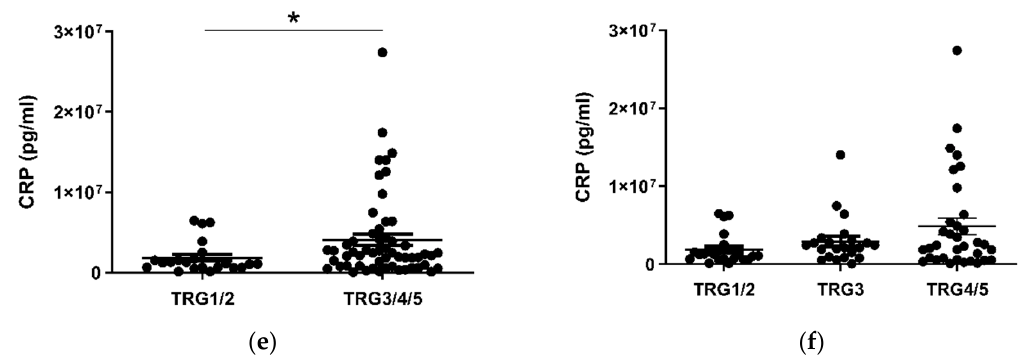
Figure 2. CCL4, Tie2 and CRP levels are altered in pre-treatment serum between TRG treatment response groups. Levels of cytokines were measured in serum of 80 patients using multiplex ELISA and grouped by TRG score. CCL4 levels were higher in patients with a low TRG score ( a ), particularly between the highest and lowest scored groups ( b ), whereas Tie2 ( c ) was higher in patients with high TRG scores, specifically those with the highest TRG ( d ). Levels of CRP were higher in patients with high TRG scores ( e ), though not when three tier analysis was used ( f ). Two group data sets were analyzed by Mann–Whitney test, and three group data sets were analyzed by ANOVA (Kruskal–Wallis test with Dunn’s multiple comparisons). * p < 0.05. ** p < 0.01. CRP = C Reactive Protein.